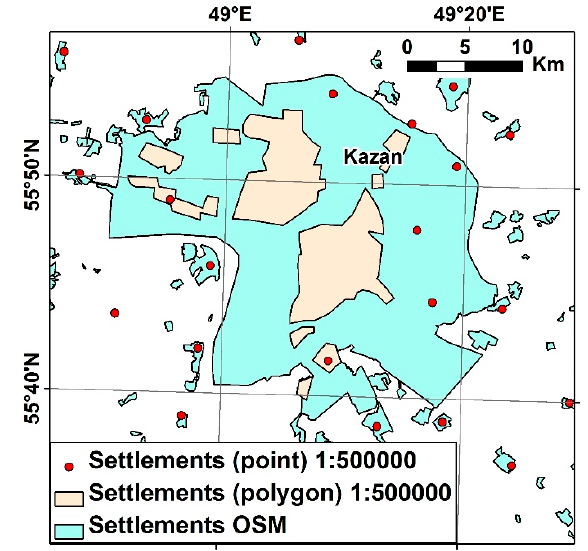
Figure 2. Updating the boundaries of settlements.